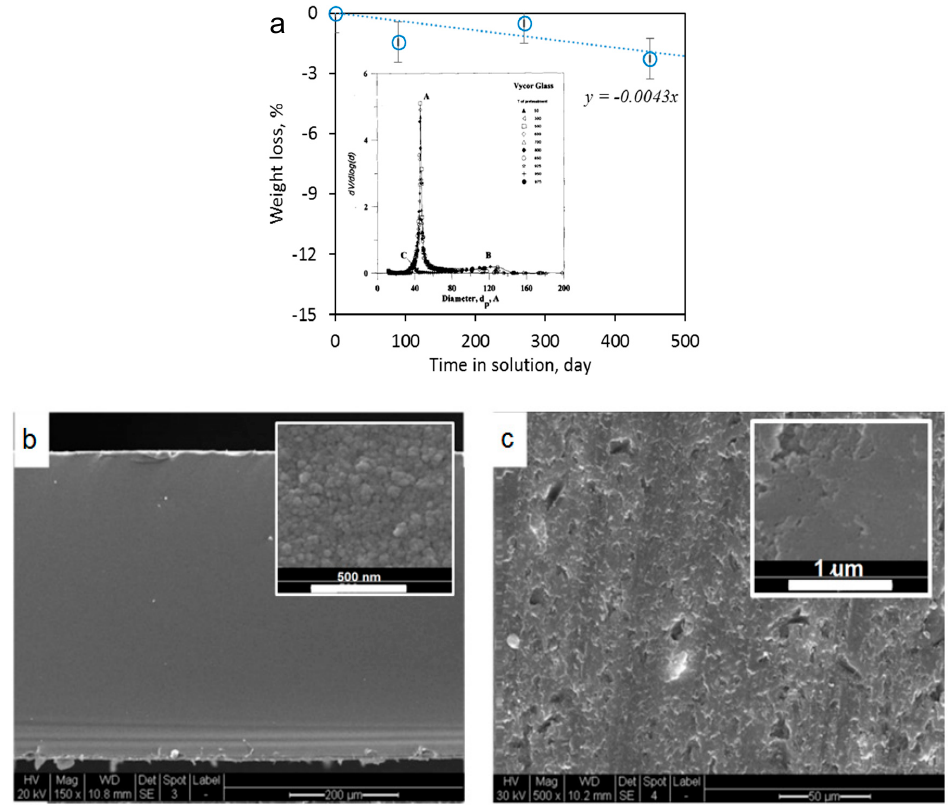
Figure 1. Characterizations of the Vycor® porous glass (VPG) membrane: ( a ) Weight loss as a function of time immersed in the solution of 2 M V 5+ (VO 2+ ) in 2 M H 2 SO 4 (insert is the pore size distribution from reference [24]), ( b ) SEM image of cross-section, and ( c ) SEM image of surface.